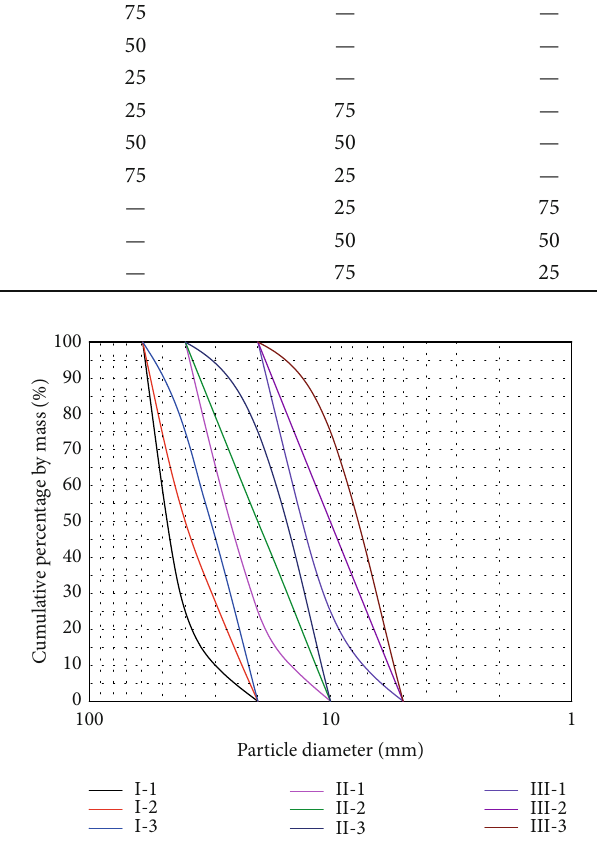
Figure 1: Particle grading of gravel samples. Table 2: Characteristic particle size of